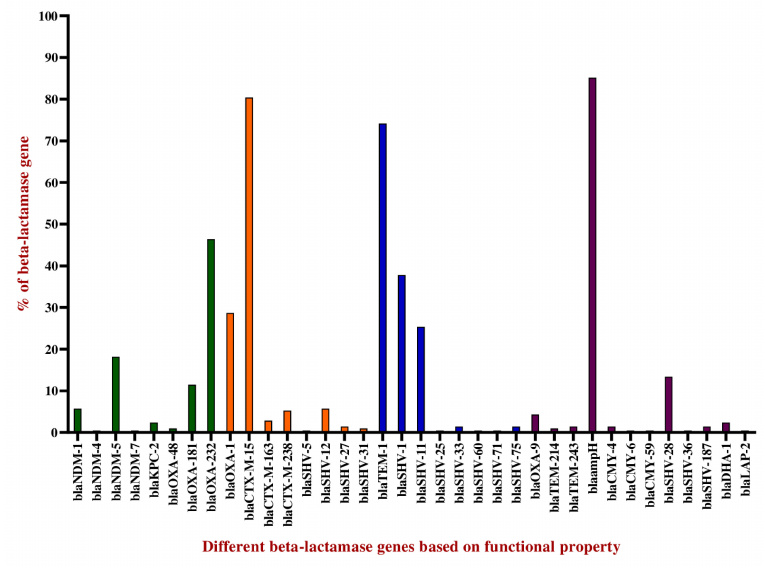
Figure 3. Percentage distribution of β -lactamase genes among strains. Bars in the graph indicate individual β -lactamase genes, in which bars in green indicate the carbapenemase gene, orange indicates ESBLs, blue indicates BSBLs, and purple indicates other β -lactamase genes. The GraphPad Prism 8.4.2 tool was used to create this graph.